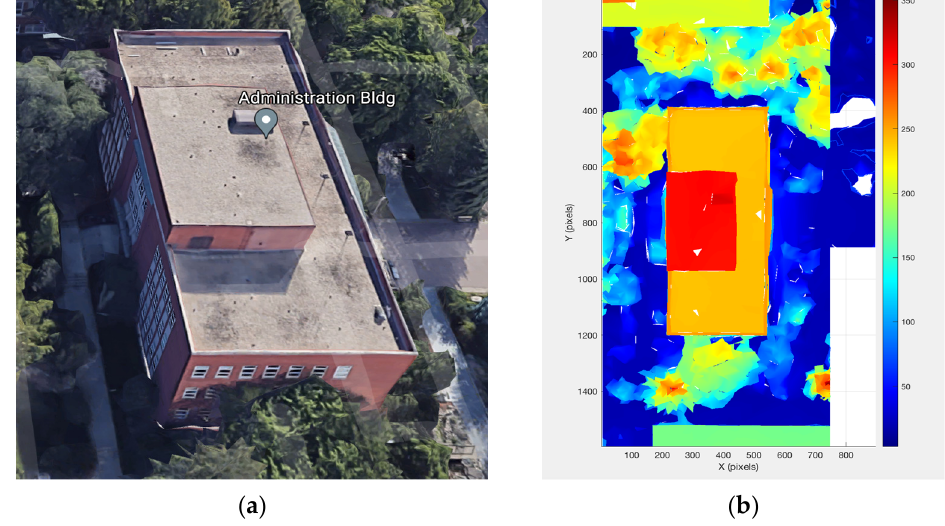
Figure 6. ( a ) Google Maps model of the ADMIN with textures (Imagery ©2021 Google, Imagery ©2021 Maxar Technologies, Map data ©2021) and ( b ) the extracted heightmap in pixels.